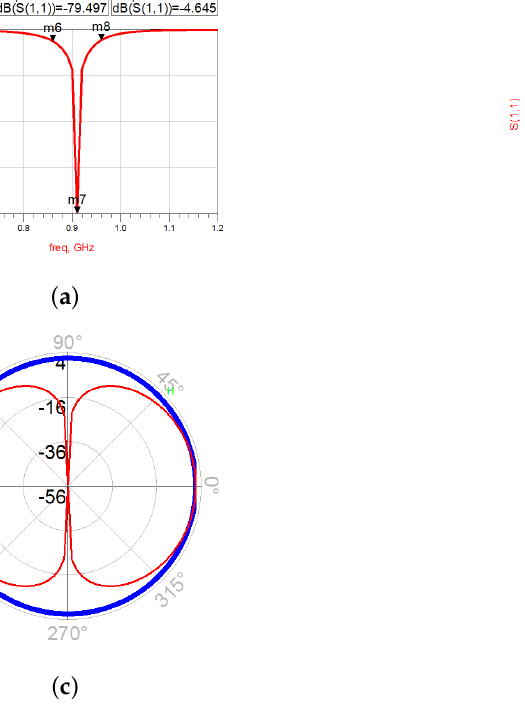
Figure 24. Antenna simulation. ( a ) Antenna S11 parameter. ( b ) Antenna impedance. ( c ) Radiation